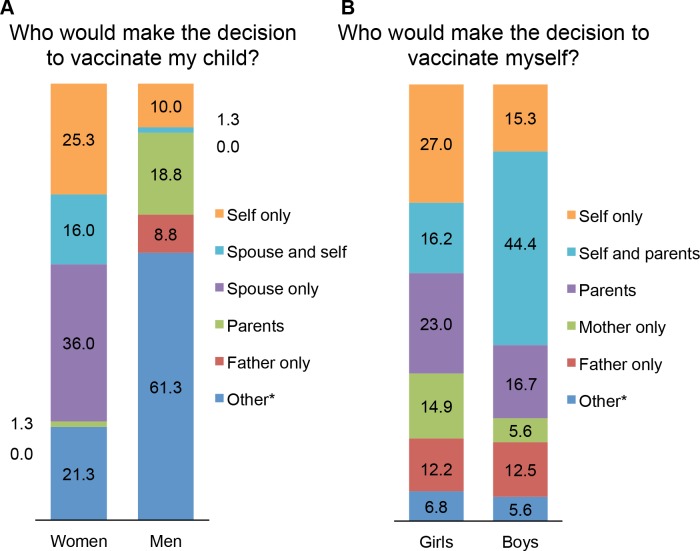
HPV Vaccination Decision-making Autonomy.Participants were asked who would participate in the decision of vaccinate their children (adults, A) or themselves (adolescents, B). Results are shown as percentage of female ≥ 18 years (Women, N = 75), male ≥ 18 years (Men, N = 80), female <18 years (Girls, N = 74) and male <18 years (Boys, N = 72). * “Other” includes participants who did not answer the question. Women reported less autonomy regarding vaccine decision-making than men regarding vaccination for themselves and their children.